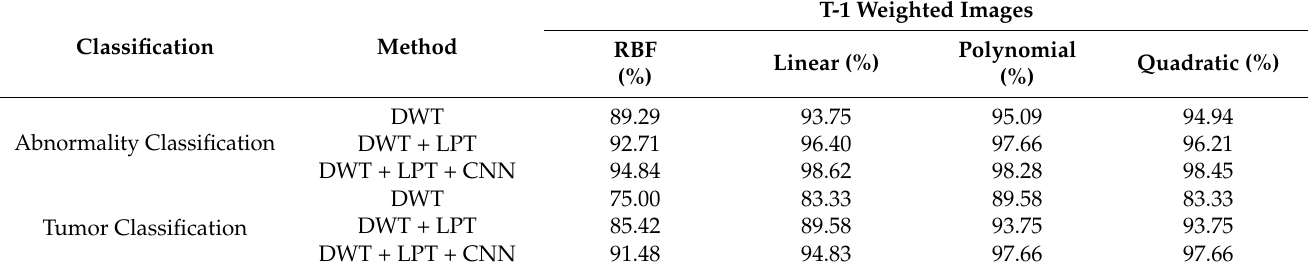
Table 5. Average T-1 weighted image